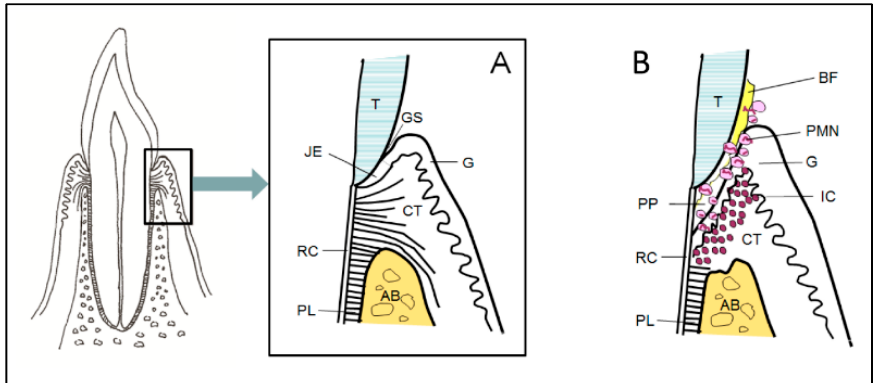
Figure 1. The anatomical structure of the periodontium in health ( A ) and in periodontitis ( B ). Abbreviations: Alveolar bone (AB), bacterial biofilm (BF), connective tissue (CT), gingiva (G), gingival sulcus (GS), inflammatory cells (IC), junctional epithelium (JE), polymorphonuclear neutrophils (PMN), periodontal ligament (PL), periodontal pocket (PP), root cementum (RC), and tooth (T).